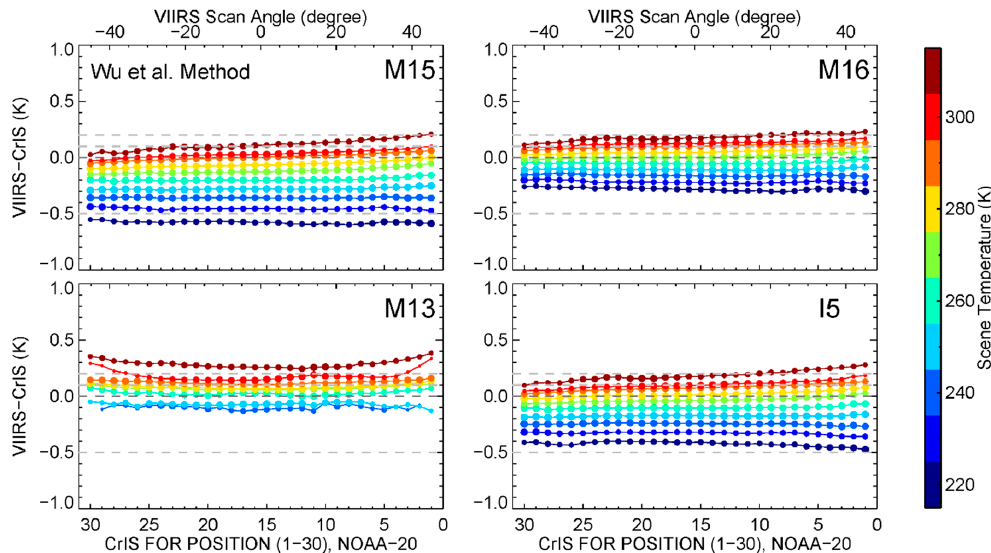
Figure 10. NOAA-20 VIIRS–CrIS BT differences at 10 scene temperatures and as functions of CrIS FOR position and VIIRS scan angle. VIIRS M15–M16, M13, and I5 SDRs from March 18, 2019 were